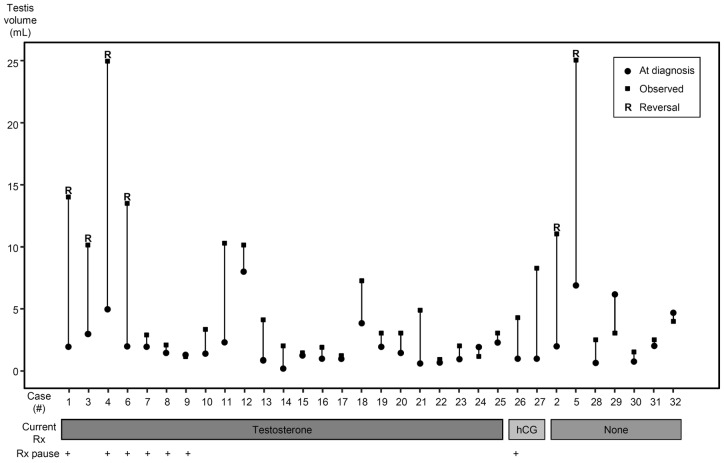
Assessment of the reversal of congenital hypogonadotropic hypogonadism (HH).Mean testicular volumes of HH patients were measured at the time of the diagnosis (solid circles) and at participation in the current study (small line). We used the value 2 mL for testicular volumes for cases #2, #6, #7, and #19 at diagnosis, because volumes were estimated to be “small" or “prepubertal" in medical records. Cases #21–25 were previously treated with recombinant-FSH and hCG to induce spermatogenesis. Seven patients (cases #1, 4, 6–9, and 26) discontinued hormone therapy, and 6 (cases #1–6) showed reversal of HH (4 during the treatment pause and 2 without TRT). In addition, #11, 13, 18, and 21 had spontaneous testis growth but they refused to discontinue TRT.